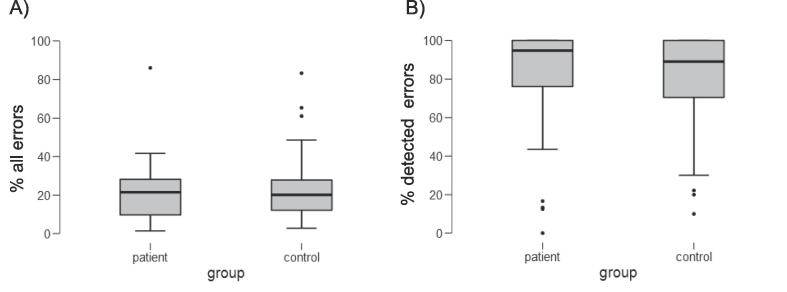
Behavioral results for error rate and error detection rate. A) The boxplot shows the percentage of all errors made after nogo-stimuli for patients and controls separately, that were significantly different from each other. B) The percentage of all detected errors amongst all errors made after nogo trials is displayed, again showing no group difference. For both boxplots, the thick line indicates the group median and error bars represent 95% confidence intervals.